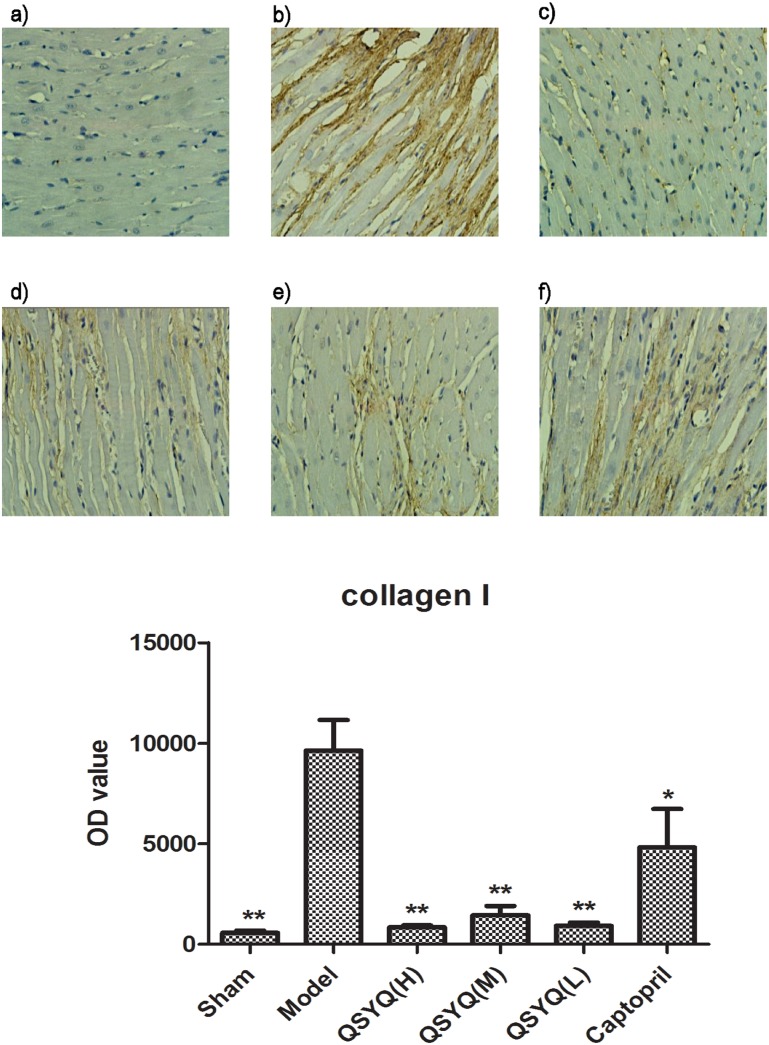
Results of Collagen I expression in different groups.The concentrations of collagens I in the model group (b) were obviously higher than those in sham group (a), indicating a cardiac remodeling in model rats. Whereas the levels of collagens I in high QSYQ (c), middle QSYQ (d) and low QSYQ groups (e) were remarkably lower than those in the model group. Captopril group (f) showed a same effect on suppressing the collagen synthesis. n = 10∼14 for each group. Quantitative analysis of collegen I was presented in (g). OD values represent the mean ± SD. *P<0.05 vs Model group, **P<0.01 vs Model group.